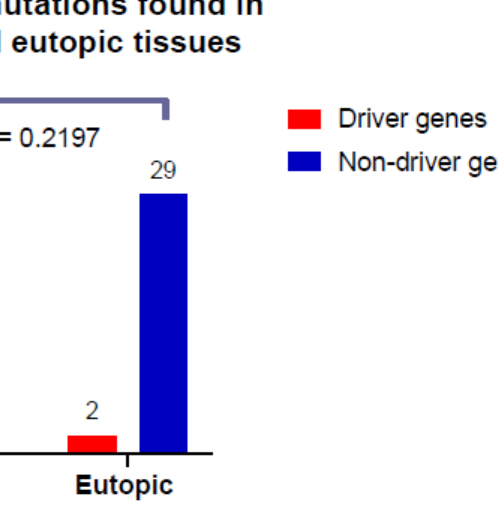
Figure 2. Number of cancer driver and non-driver mutations found in ectopic end eutopic tissues. Calculated using Fisher’s exact test.